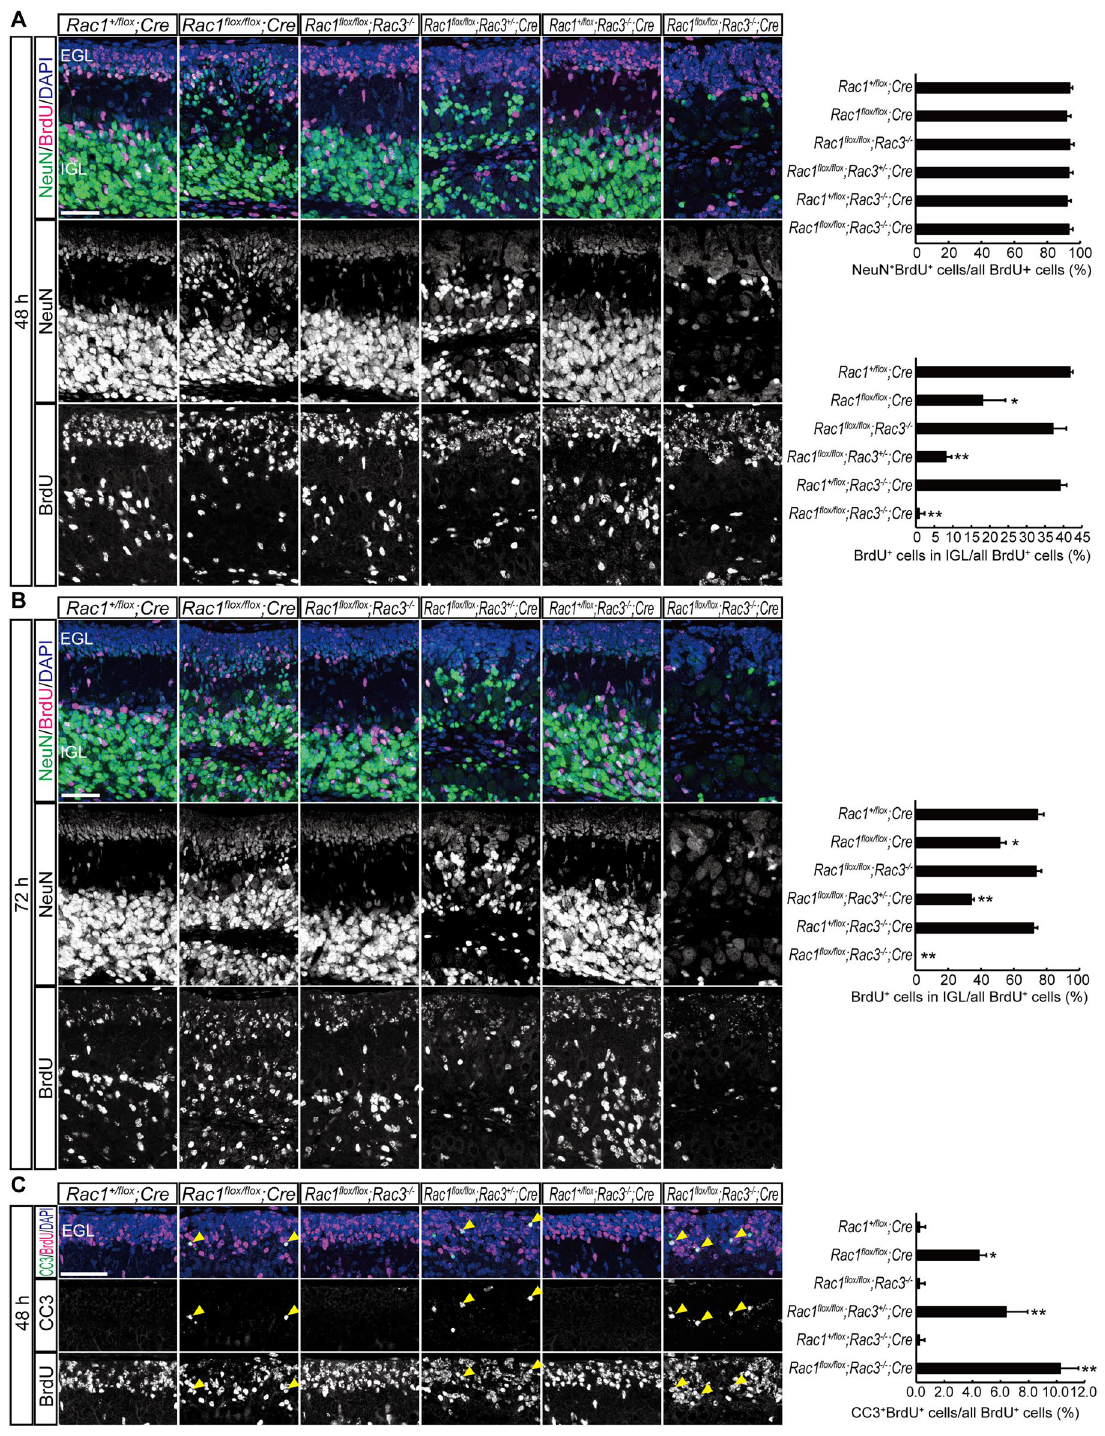
Figure 4. Newly generated granule neurons can differentiate into NeuN-positive cells but hardly reach to the IGL in Rac1 flox/flox ; Rac3 −/− ; Cre mice. Immunohistochemistry for BrdU and NeuN of the sagittal section of the anterior part of the lobule IV ( A , B ). Mice were injected with BrdU on P7 and sacrificed 48 h ( A ) or 72 h ( B ) after the injection. Most of the BrdU-incorporated cells differentiate into NeuN-positive cells in 48 h in each genotype. Significantly fewer BrdU-incorporated cells migrate to the IGL in Rac1 flox/flox ; Cre , Rac1 flox/flox ; Rac3 +/− ; Cre and Rac1 flox/flox ; Rac3 −/− ; Cre mice at 48 h and 72 h. Immunohistochemistry for BrdU and cleaved Caspase-3 (CC3) of the sagittal section of the anterior part of the lobule IV ( C ). Mice were injected with BrdU on P7 and sacrificed 48 h after the injection. The proportion of CC3 + /BrdU + cells (arrowheads) among all BrdU + cells was significantly increased in Rac1 flox/flox ; Cre , Rac1 flox/flox ; Rac3 +/− ; Cre and Rac1 flox/flox ; Rac3 −/− ; Cre mice. Each bar represents mean + SD (n = 3). * P < 0.05, ** P < 0.01 (significantly different from Rac1 + /flox ; Cre mice), one-way ANOVA followed by a Tukey’s post hoc test. Scale bars, 50